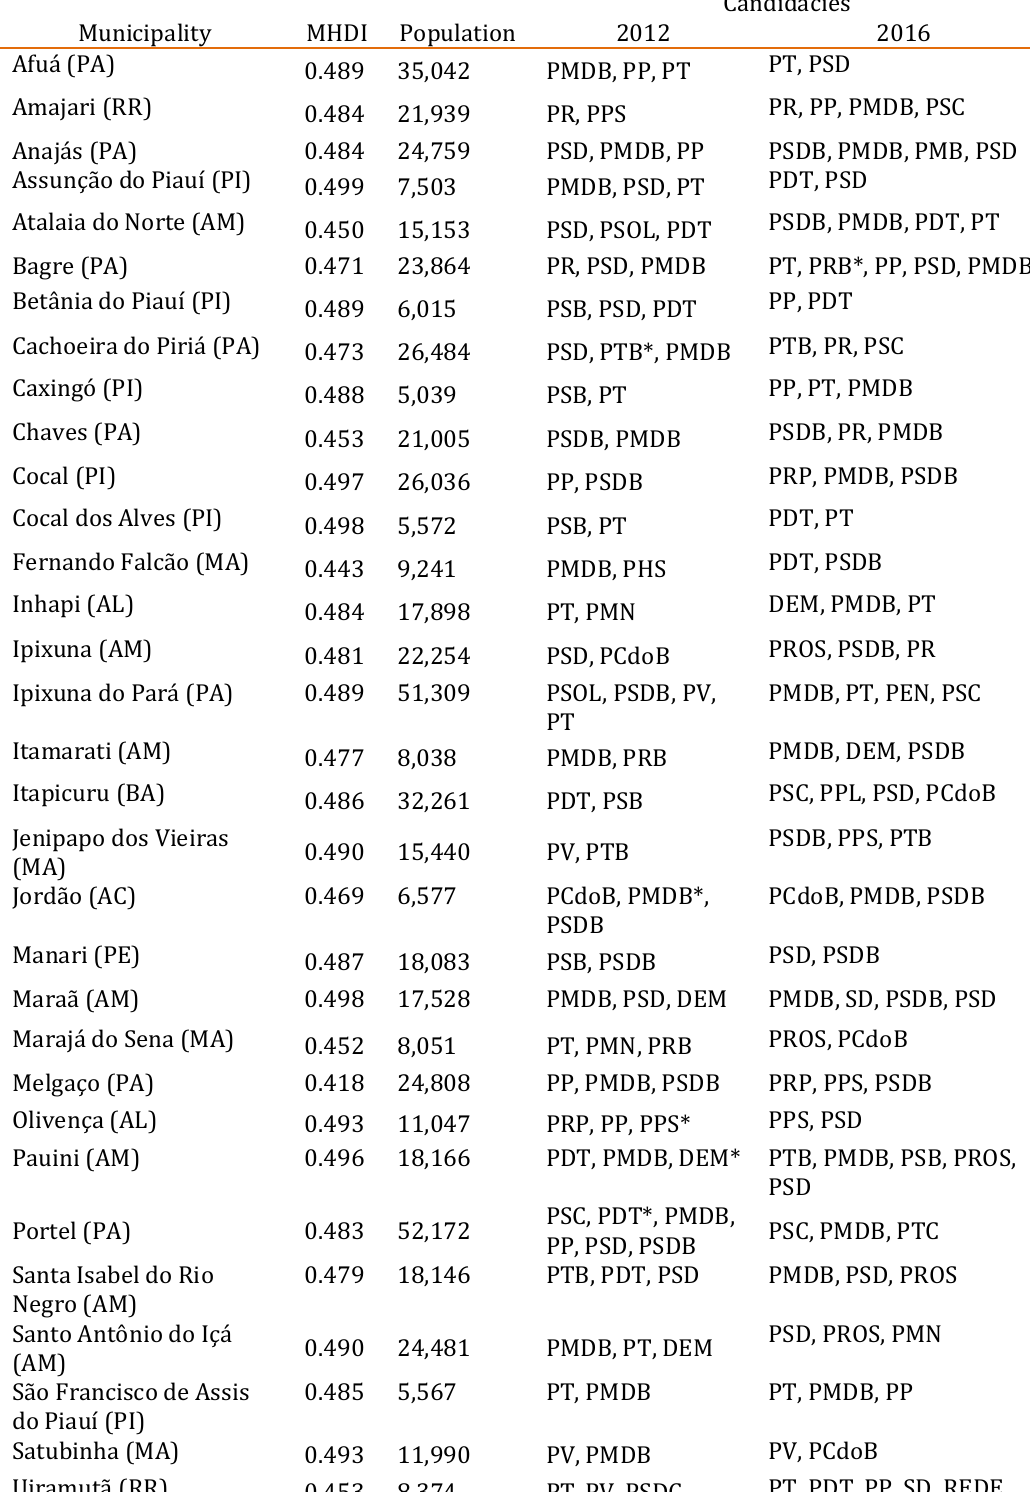
Table 01. Profile of municipalities and mayoral